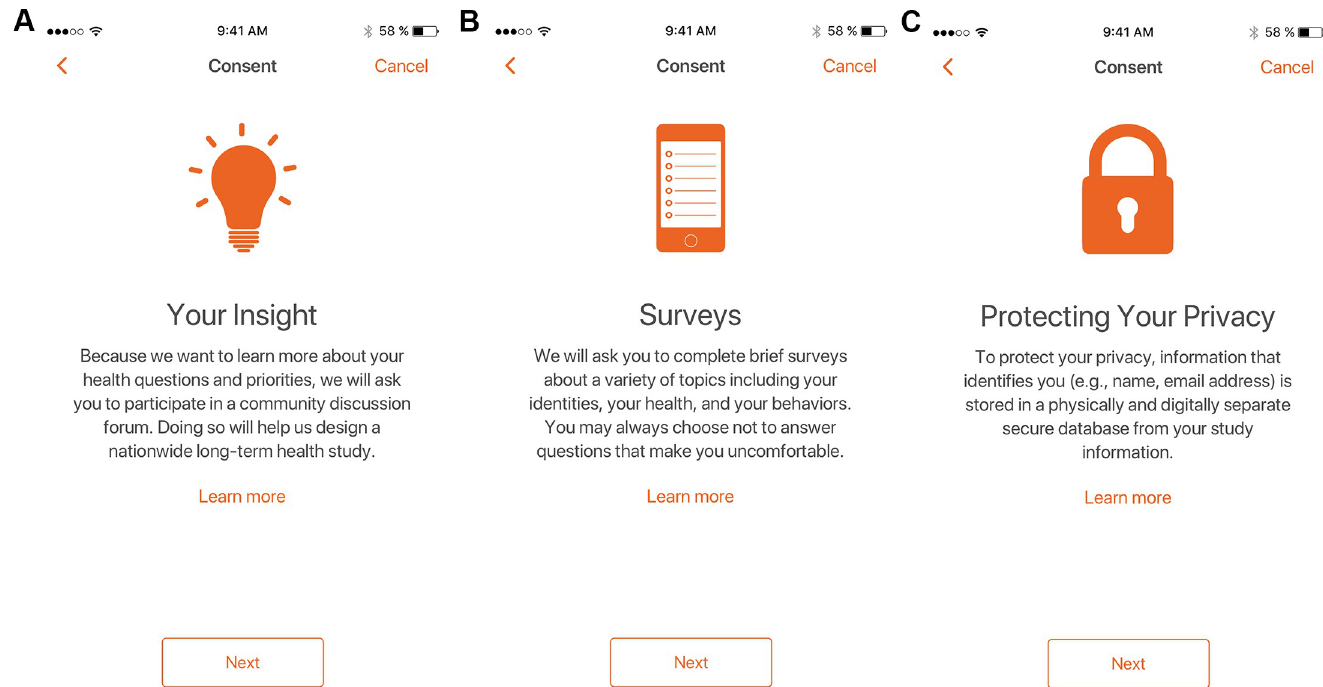
Fig 3. The PRIDE study iPhone app: Informed consent. (A-C) Example screens to guide participants step-by-step through informed